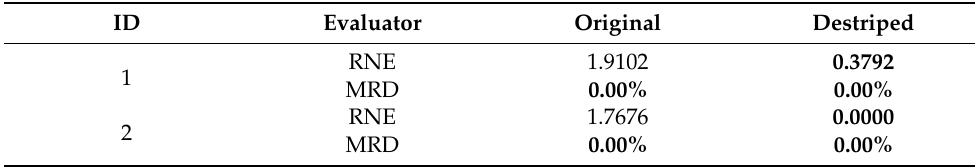
Figure 11. Destriping results of two full-size images. ( a ) Original Image 1. ( b ) Destriped Image 1. ( c ) Original Image 2. ( d ) Destriped Image 2. ( a – d ) All images have been processed by logarithmic stretching for better visualizations. Table 5. Quantitative indicators of full-size image